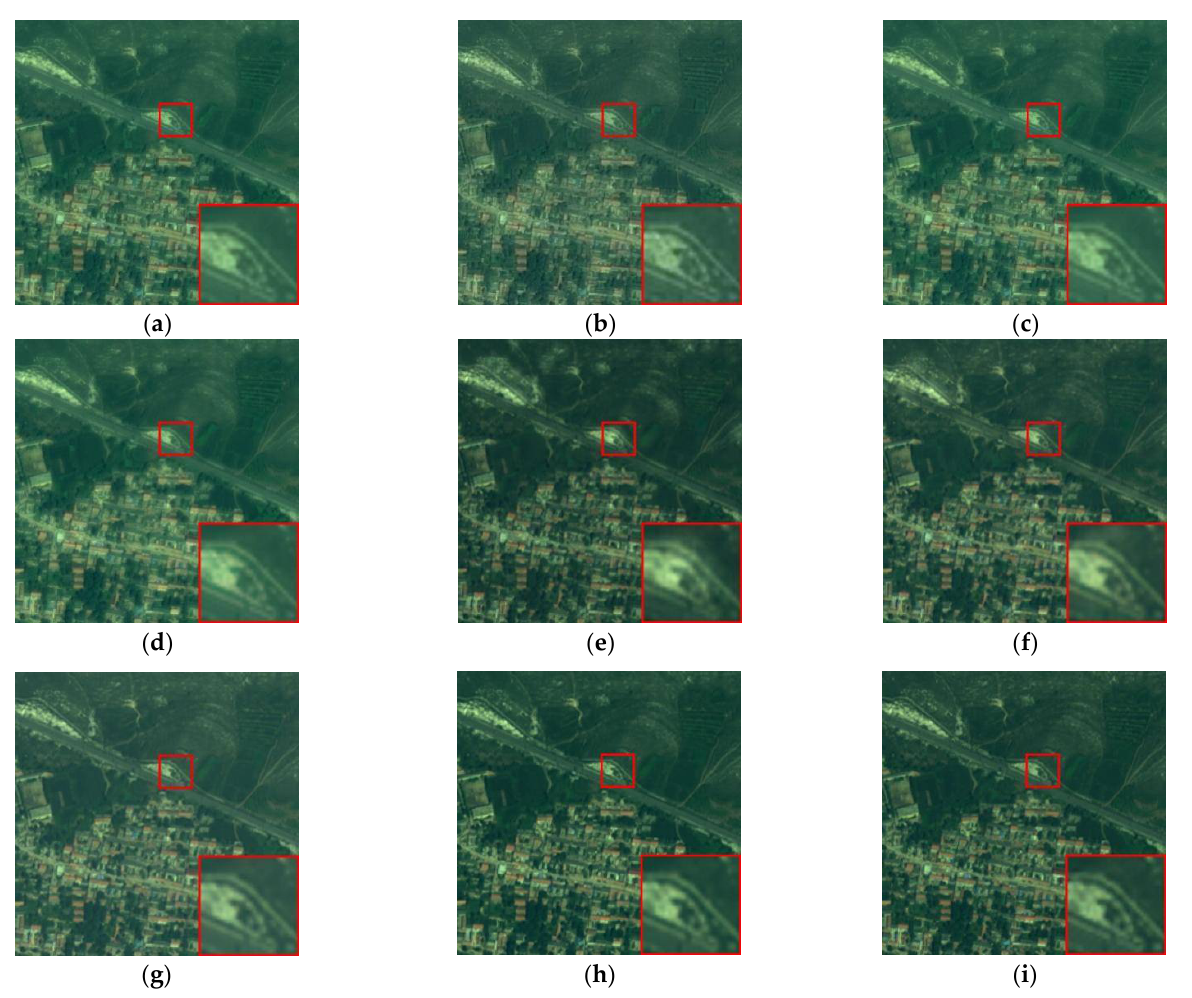
Figure 10. Fused images of WorldView-2 where ( a ) IHS, ( b ) Wavelet, ( c ) HPF, ( d ) PRACS, ( e ) PNN, ( f ) Fusion-Net, ( g ) SSConv, ( h ) DS-MDNP, and ( i ) GT.